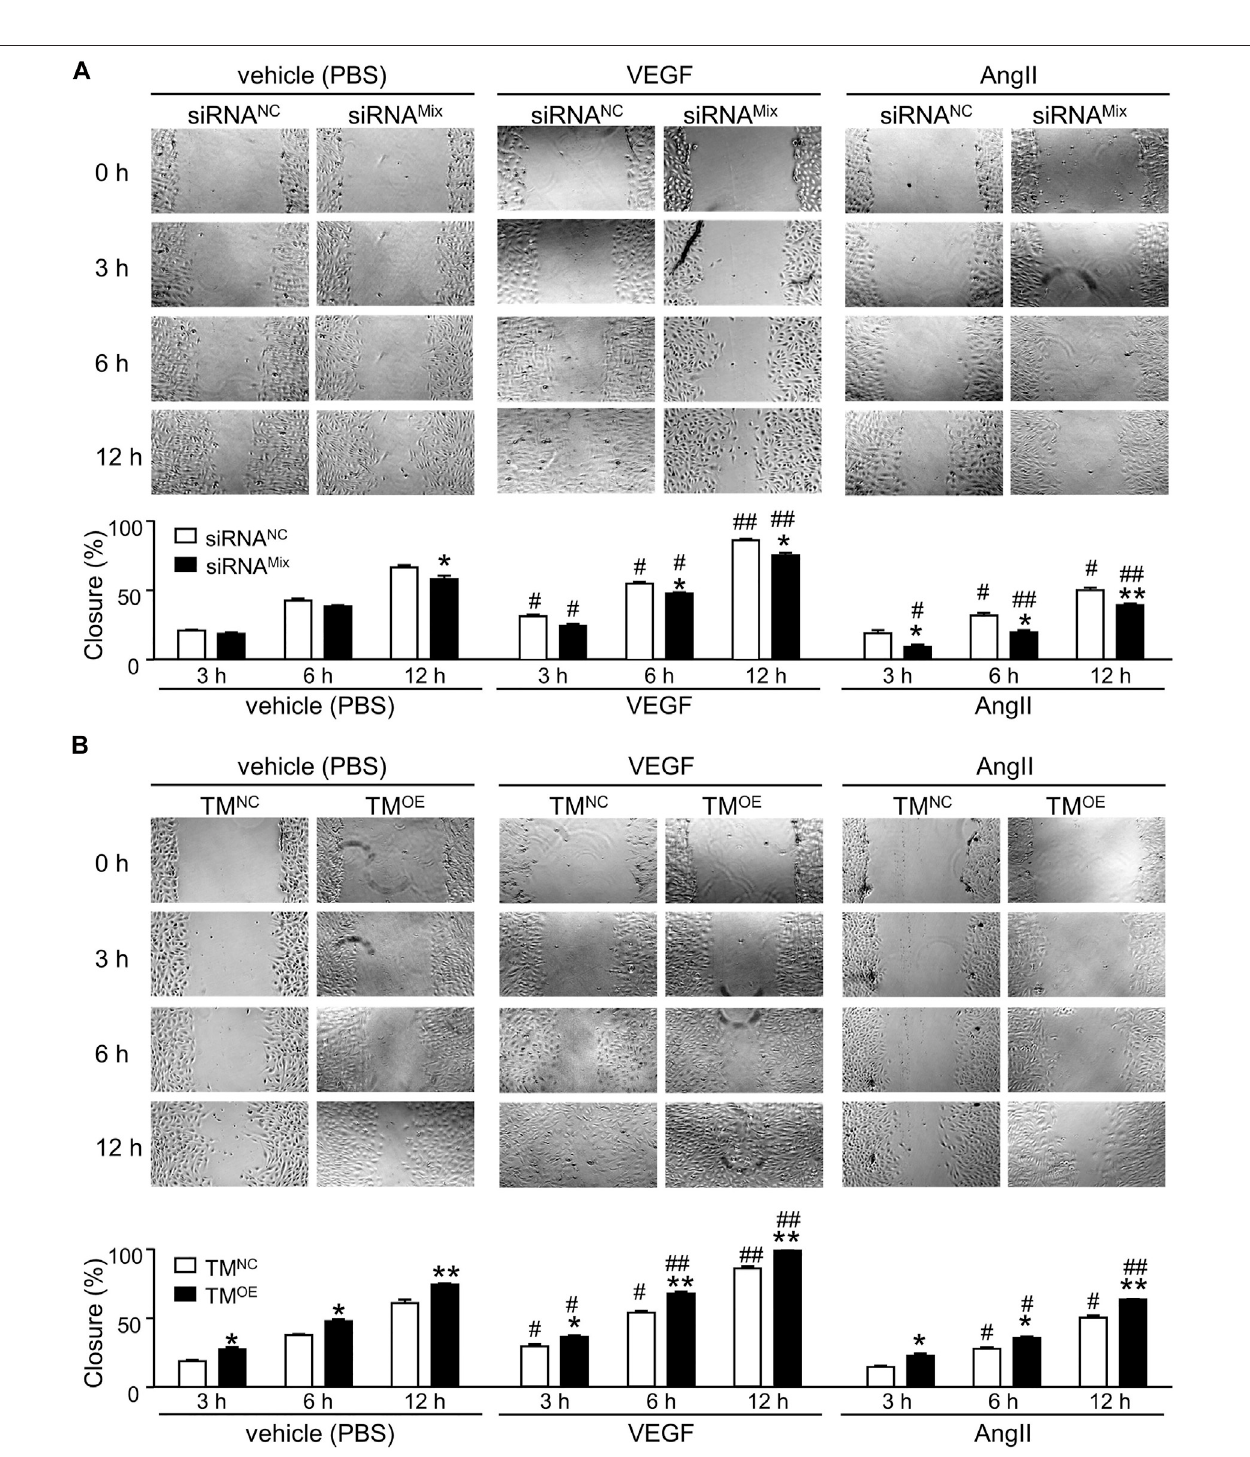
FIGURE 6 | Effect of TMEM16A on migration in HUVECs. (A) Wound healing assay results of HUVECs transfected with siRNA NC or siRNA Mix , and treated with vehicle(PBS),orVEGF(30 ng/mL),orAngII(1 μ M)separately( n =5 — 8ineachgrouppertimepoint). (B) WoundhealingassayresultsofHUVECstransfectedwithTM NC or TM OE ,and treatedwithvehicle (PBS),orVEGF (30 ng/mL), or AngII(1 μ M) separately (n= 5 – 7in each group per time point). * p < 0.05 and ** p < 0.01 compared with siRNA NC or TM NC under the same treatment and at the same time point, # p < 0.05 and ## p < 0.01 compared with vehicle (PBS) in the same cell type and at the same time point, RM two-way